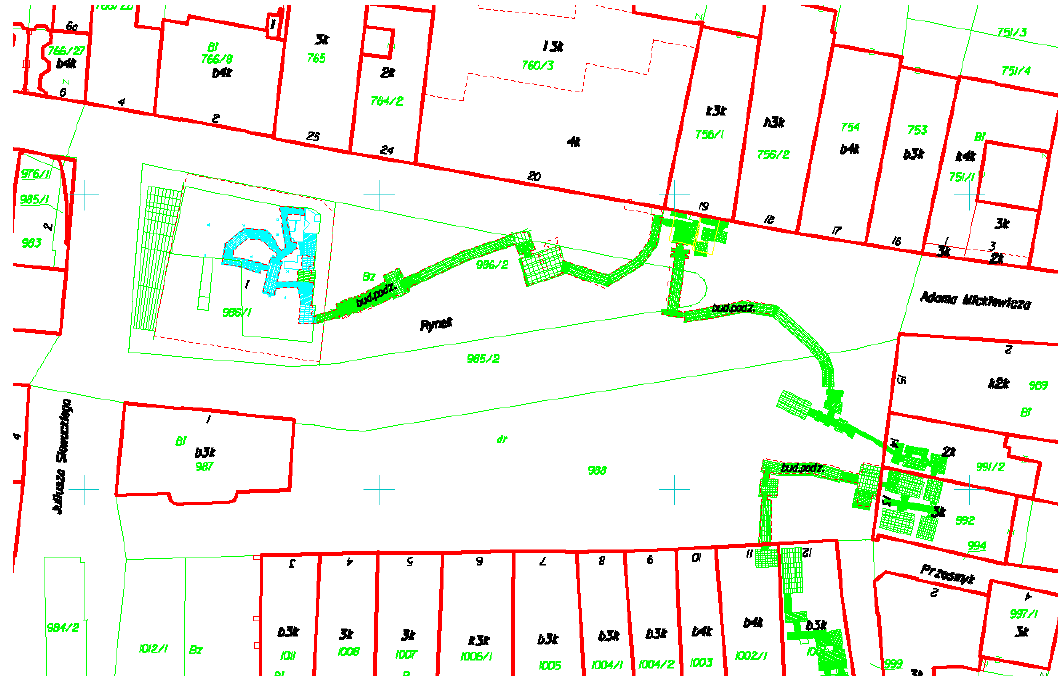
Figure 7. Rzeszów cadastral map with the Underground Tourist Route included (blue and green). Figure 7. Rzesz ó w cadastral map with the Underground Tourist Route included (blue and green). Source: own study. Source: own